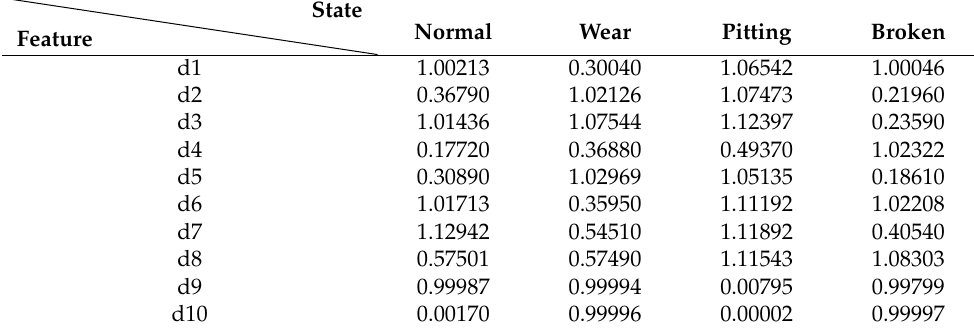
Table 6. Eigenvalues from the parallel fusion